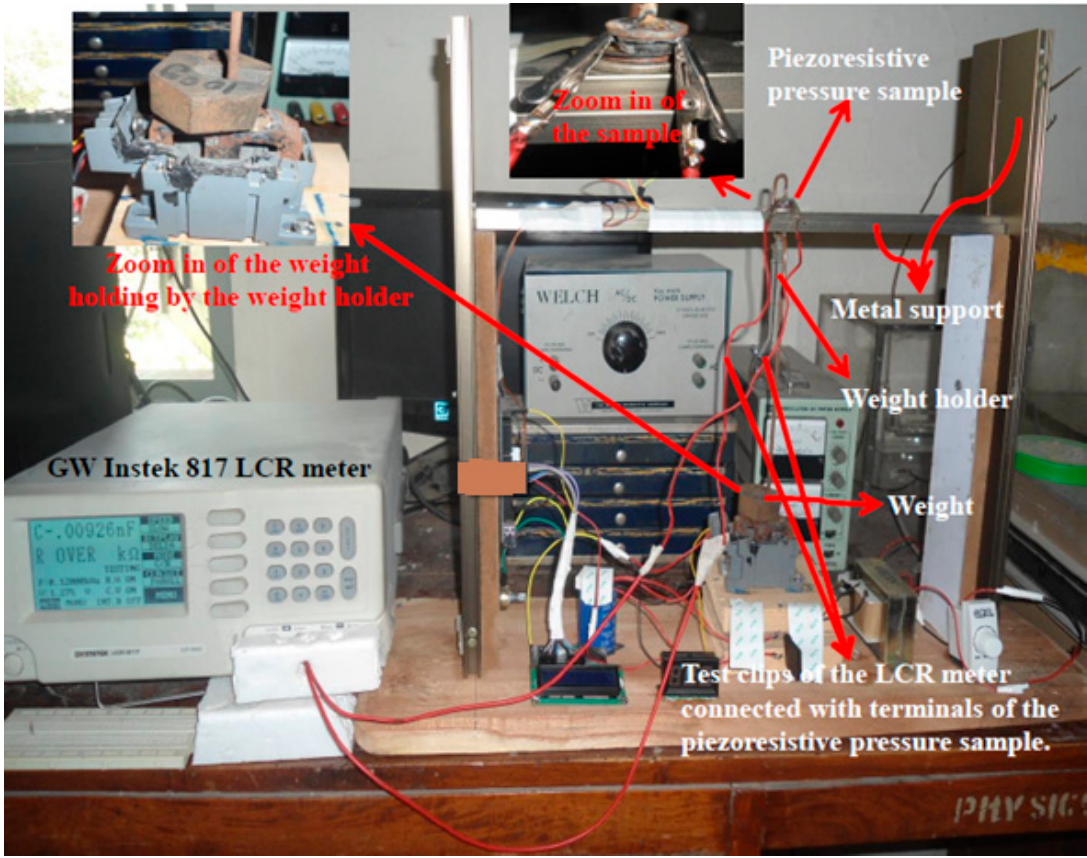
Figure 4. Experimental setup for the characterization of piezoresistive pressure samples.